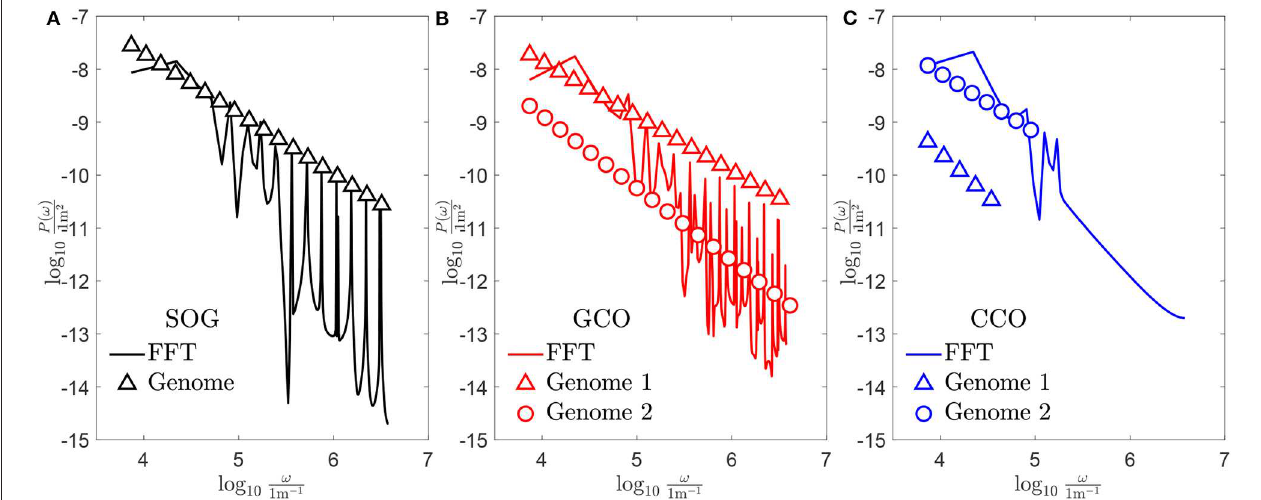
FIGURE 11 | Power spectral density of the obtained new genomes, whose associated profiles are shown in Figure 10 : (A) case of the SOG algorithm; (B) case of the GCO algorithm; (C) case of the CCO